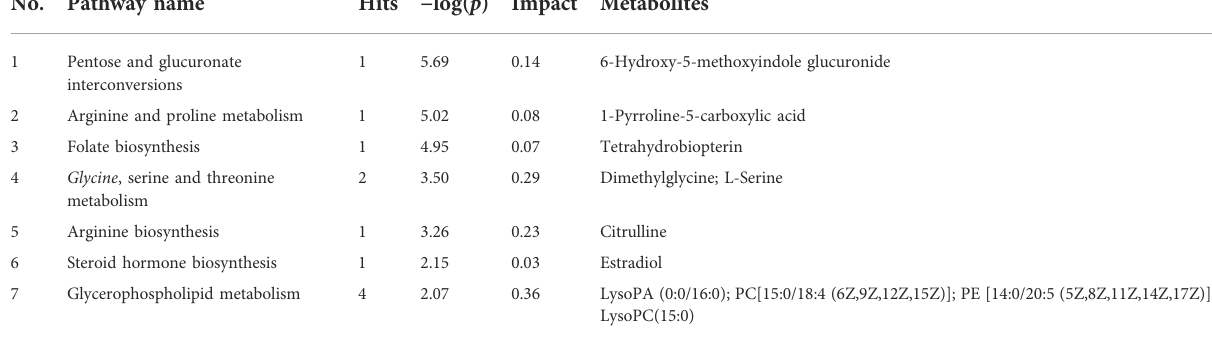
TABLE 2 Results of metabolic pathway